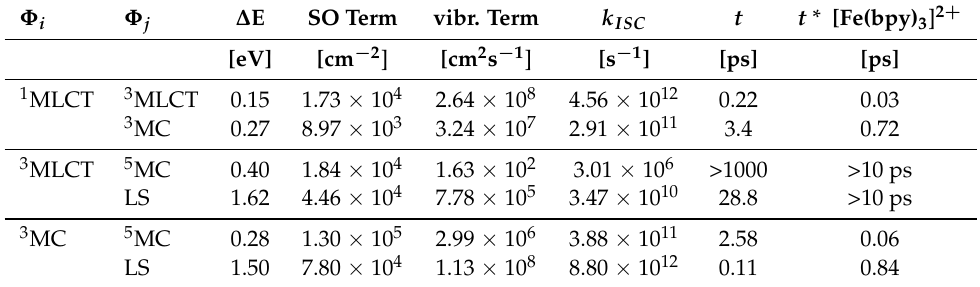
Table 4. Intersystem crossing rates ( k ISC ) obtained from Fermi’s golden rule for the decay between electronic states of different spin in [Fe(bpy) 2 (CN) 2 ]. Adiabatic energies, vibrational and spin-orbit contributions are also